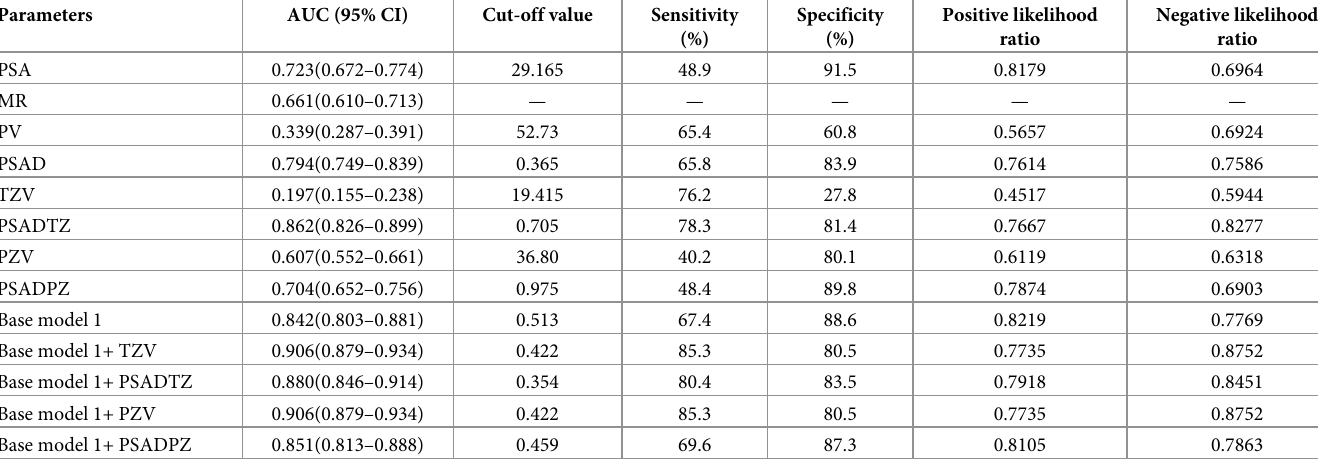
Table 5. The AUC and cut-off values for predicting biopsy outcome and their sensitivity, specificity, positive and negative likelihood ratios for PCa and no PCa. Parameters